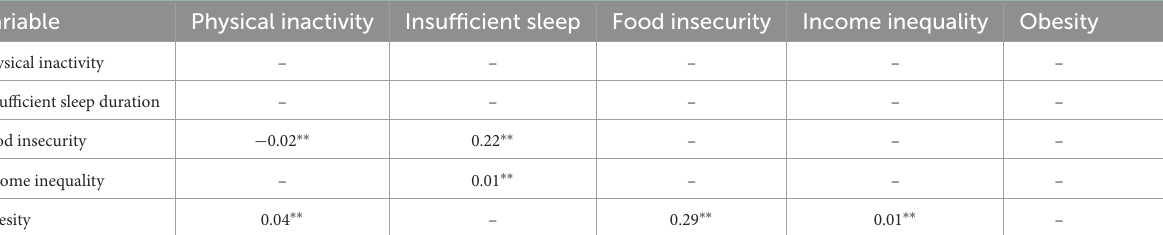
TABLE 3 Path analysis indirect